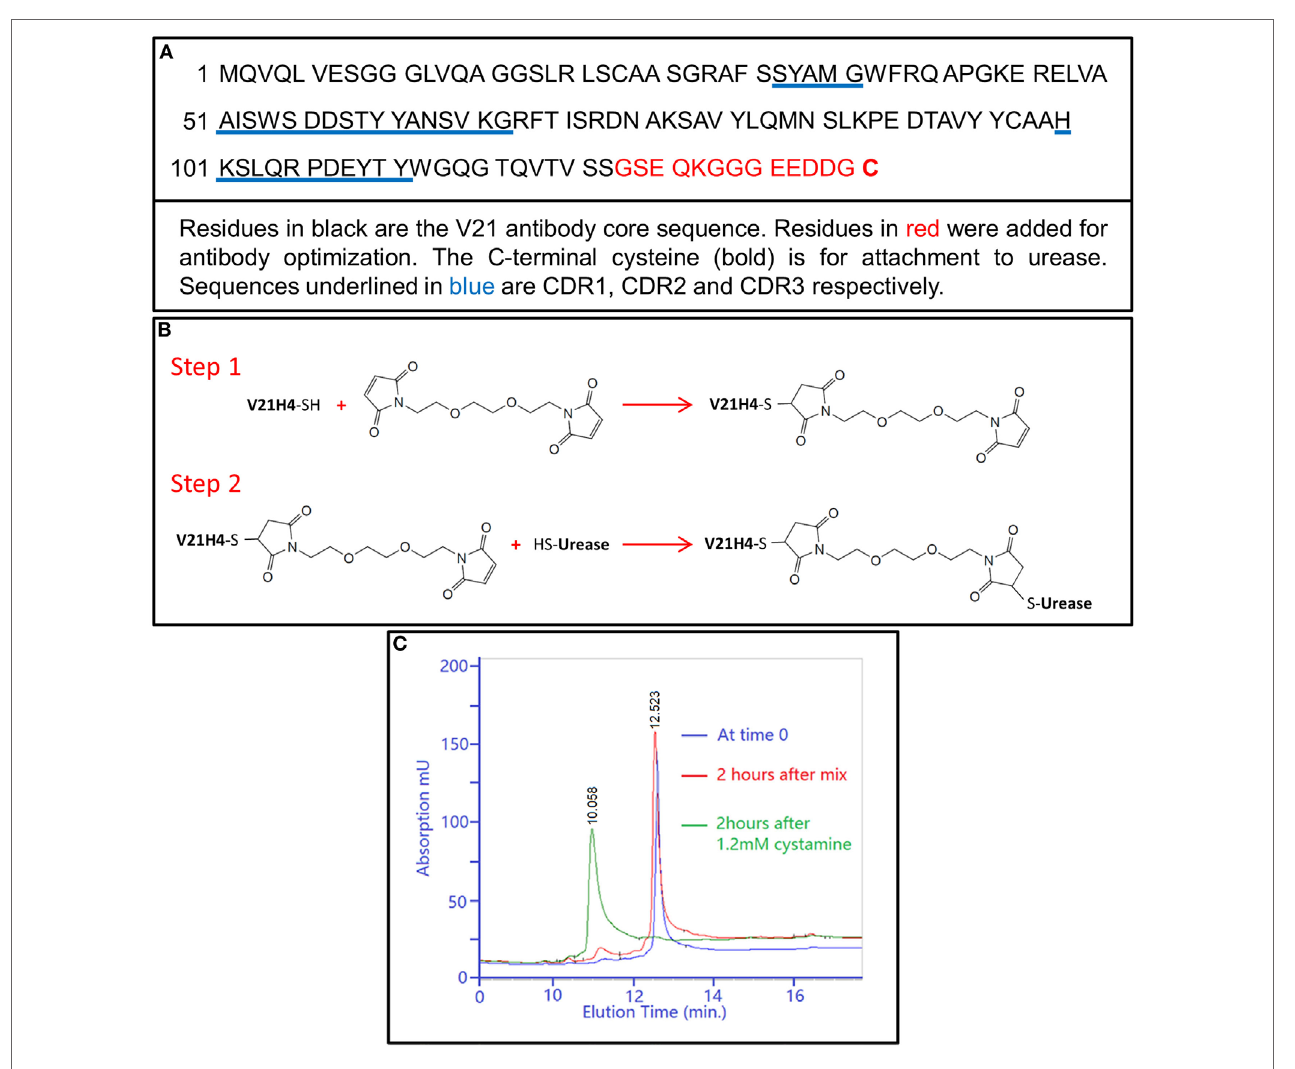
FigUre 3 | (a) Amino acid sequence of the V21H4 antibody. (B) Description of conjugation strategy used to conjugate V21H4 to urease to generate V21H4- DOS47. Step 1 is the activation of the antibody using BM(PEG) 2 . Step 2 conjugates the activated antibody to urease. (c) RP-HPLC chromatograms of V21H4 samples at different refolding time points. Blue line: sample at refolding time 0, immediately after the SP pooled fraction was mixed with refolding buffer. Red line: refolding time point 2 h after mixing. Green line: refolding sample 4 h after time 0 and 2 h after addition of 1.2 mM cystamine. Unfolded antibody elutes at 12.513 min and folded antibody elutes at 10.958